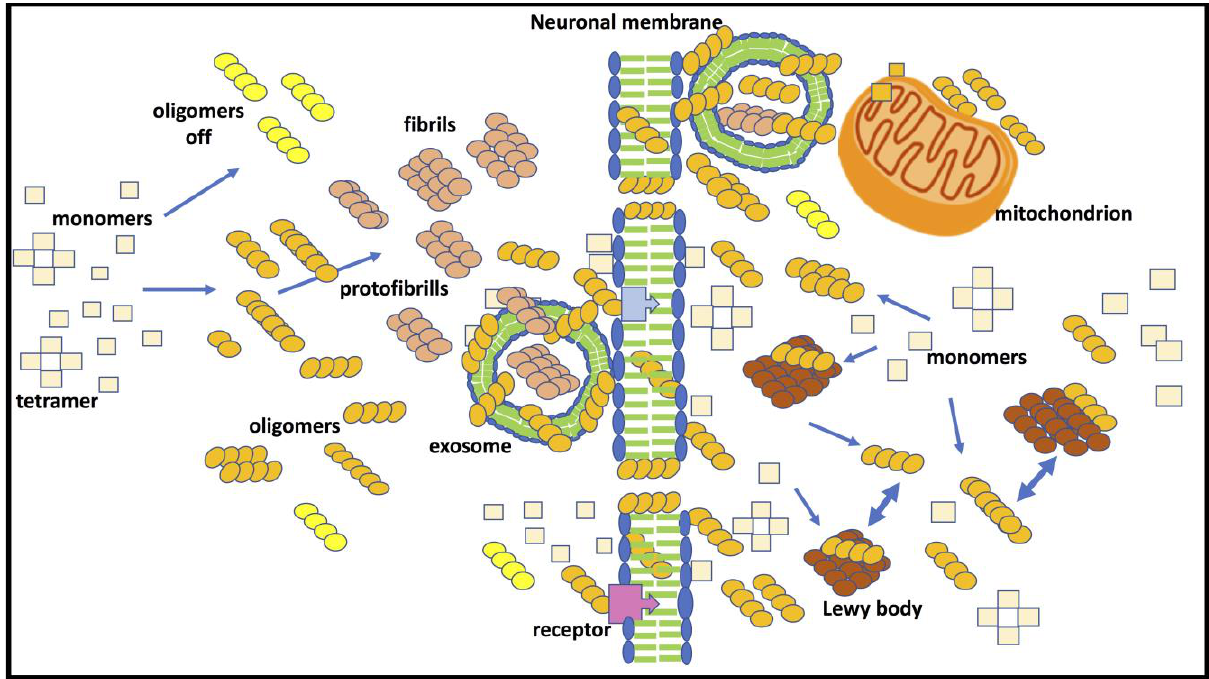
Figure 2. α -Syn and neuronal dysfunction. The fibrillogenic process from monomers to Lewy bodies passes through soluble aggregates with α -Syn oligomer as an intermediate conformer. These soluble aggregates may interact directly with neuronal membrane through specific acceptor, pore formation or unspecific interference with double lipid structure. Endocytosis and exocytosis through exosomes may contribute to the formation of Lewy bodies and cell-to-cell spread of the pathology. The progress of α -Syn oligomers to protofibrils and fibrils is not inevitable, and in specific conditions, stable oligomers can be formed (oligomer off) with no further assembling.